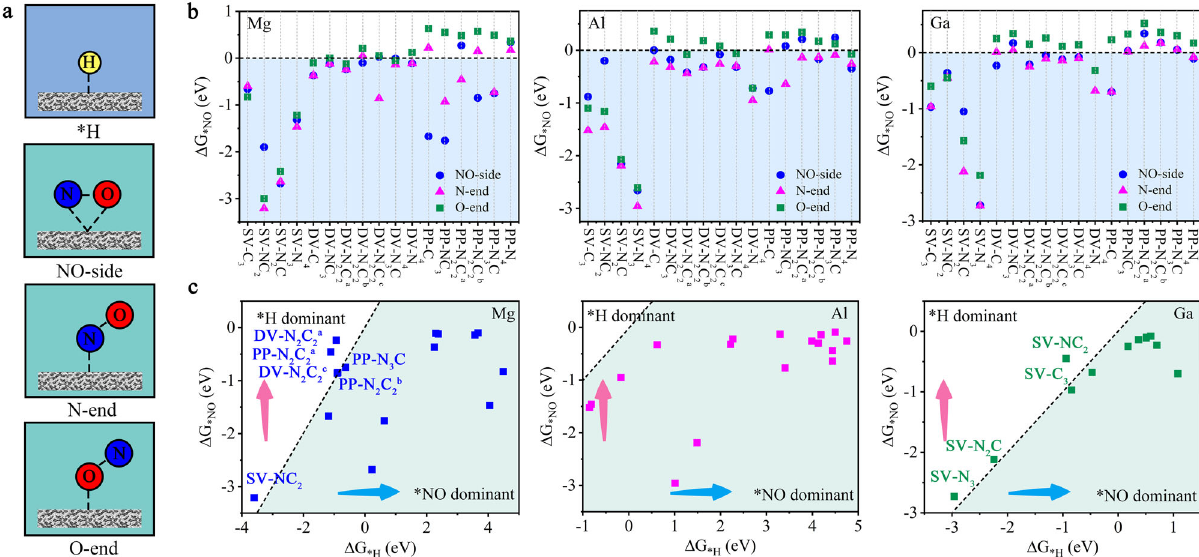
Fig. 2 Adsorption performance of NO molecule and selectivity between the adsorptions of NO and H on SAC candidates. a The possible adsorption patterns of H and NO (i.e., N-end, O-end and NO-side patterns). b Gibbs free energy changes for NO adsorption with N-end, O-end and NO-side patterns. c Comparison of the adsorption free energies of H proton and NO molecule with the corresponding most favorable adsorption